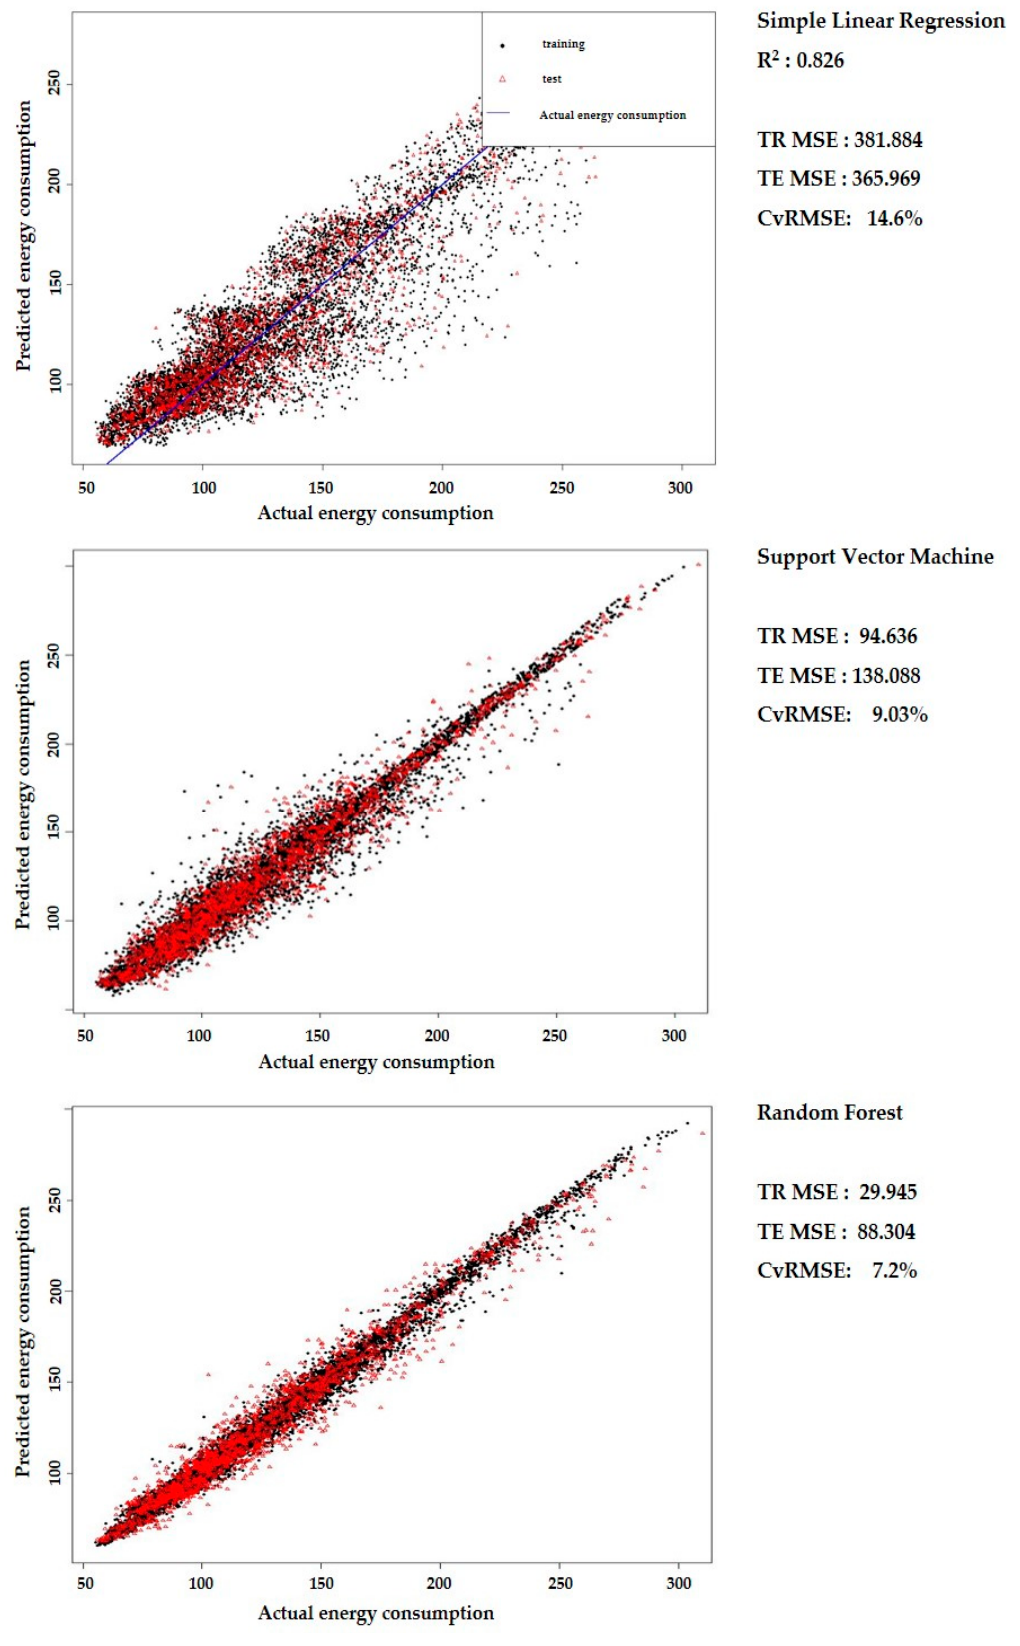
Figure 11. Results of the simple linear regression, support vector machine, and random forest analyses using only the major variables.